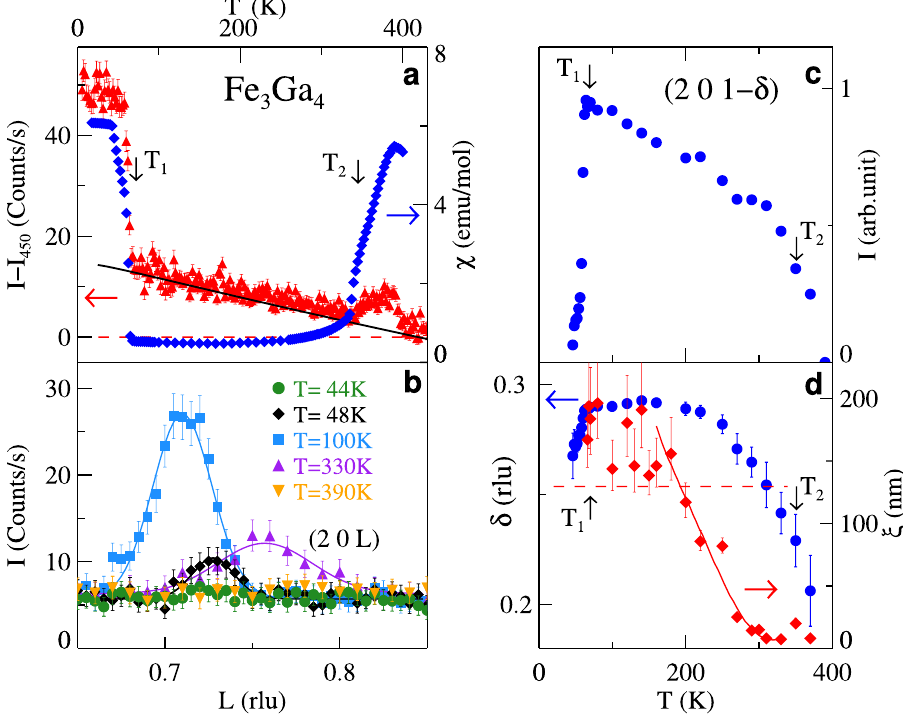
Figure 2. Temperature dependent magnetic scattering and magnetic susceptibility. ( a ) Neutron scattering intensity at the (201) Bragg peak position, I − I 450 , (red triangles) and magnetic susceptibility, χ , at 100 Oe (blue diamonds) vs. T . I − I 450 is the intensity, I , measured after subtraction of the intensity at 450 K, I 450 . Solid line is a fit of the Debye model 43 to the data between 90 and 300 K with Θ D = 125 K 20 . ( b ) Scattering along the (2 0 L ) direction at several representative temperatures demonstrating the incommensurate order. ( c ) Integrated intensity of the scattering at (2 0 1 − δ ) vs. T . ( d ) T dependence of δ (blue bullets) and the correlation length of the incommensurate scattering, ξ , (red diamonds) vs. T . Solid line is a guide to the eye. Dashed line is the instrumental resolution. Transition temperatures T 1 and T 2 are indicated in frames a, c, and